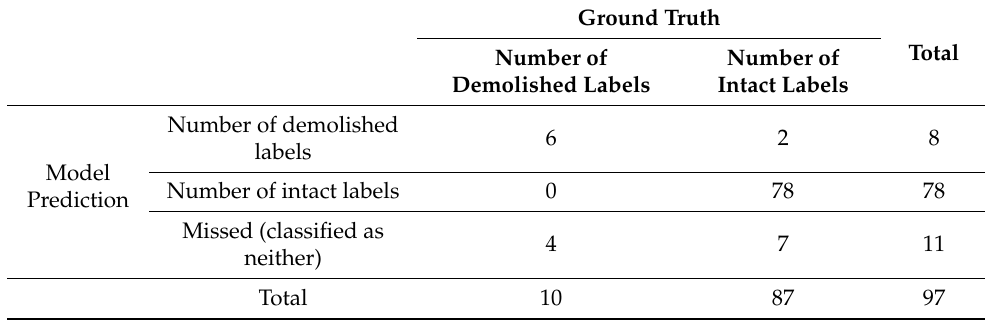
Figure 7. Network prediction after the 2017 M 7.1 Pueblo earthquake in Mexico: ( a 1 , a 2 ) satellite imagery tiles labeled as demolished (red) and intact (blue) buildings; ( b 1 , b 2 ) network’s prediction of intact building instances; ( c 1 , c 2 ) network’s prediction of demolished building instances. Satellite images from Google Earth; all rights reserved. Red x indicates footprints mis-classified or missed by the network. Table 4. Confusion matrix against the labels for the 2017 Pueblo, Mexico, earthquake testing